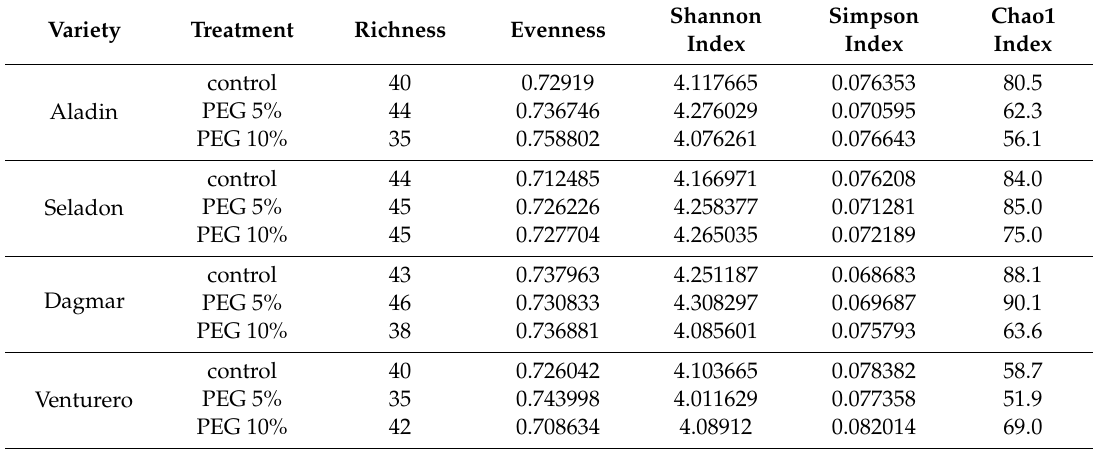
Table 1. Summary of alpha diversity indices for diversity among the analyzed wheat endophytes.